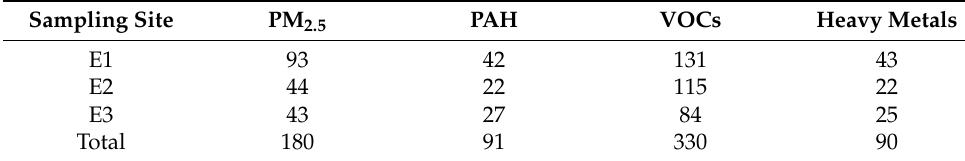
Table 2. Number of samples per sampling site. Sampling